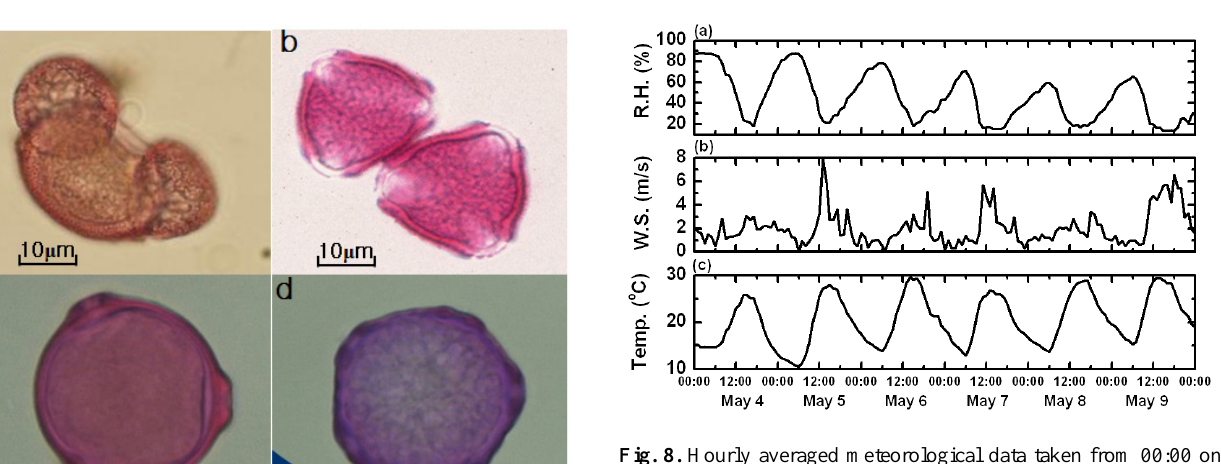
Fig. 8. Hourly averaged meteorological data taken from 00:00 on 4 May to 24:00 on 9 May 2009. (a) Relative humidity, (b) wind speed, and (c)